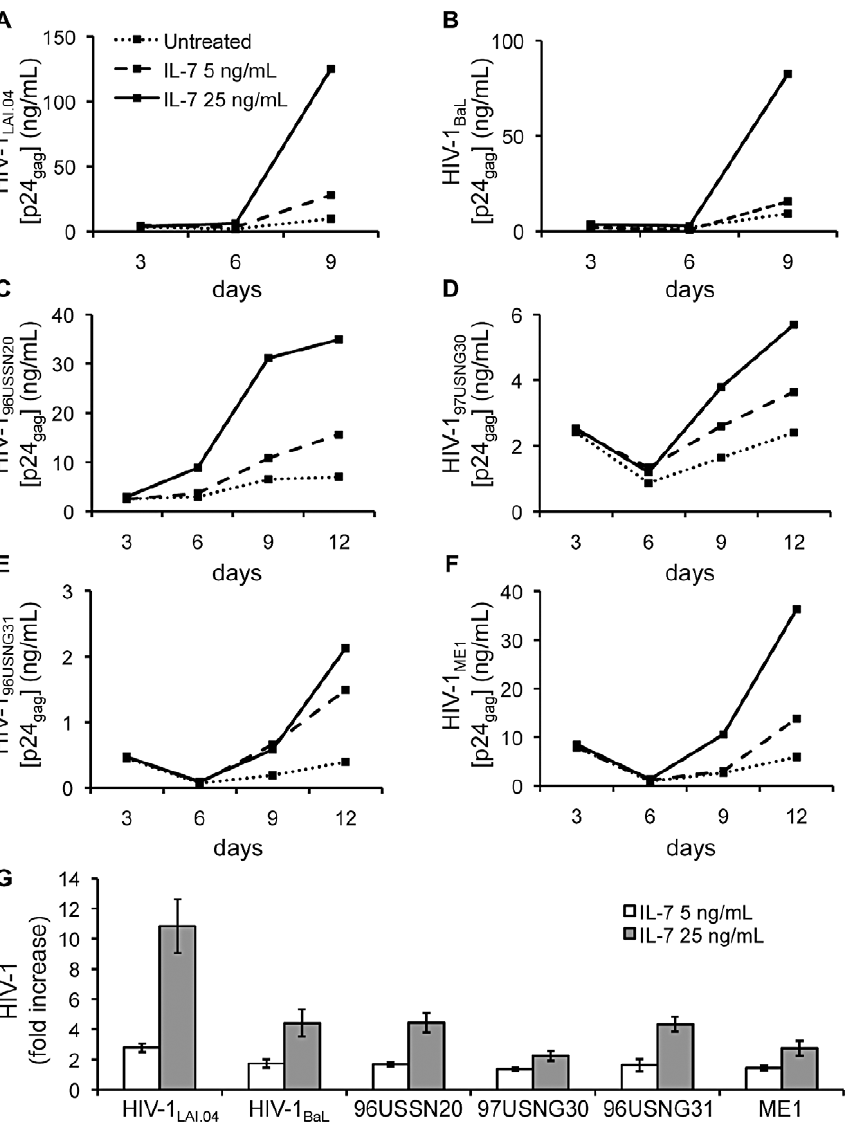
Figure 1. IL-7 enhances HIV-1 production in lymphoid tissue explants. Donor-matched lymphoid tissue blocks were inoculated with an X4 or R5 HIV-1 variant, HIV-1 LAI.04 and HIV-1 BaL respectively, or with the primary isolates HIV-1 96USSN20 (R5/X4 clade A), HIV-1 97USNG30 (R5 clade C), HIV- 1 96USNG31 (R5/X4 clade C), and HIV-1 ME1 (R5 clade B) and cultured for 9 or 12 days in the absence or presence of recombinant human IL-7 5 or 25 ng/ mL. HIV-1 replication was monitored from measurements of HIV-1 p24 gag accumulated in culture media over 3-days periods. Presented are kinetics of the release of HIV-1 p24 gag in culture media of tissue blocks inoculated with HIV-1 LAI.04 ( A ), HIV-1 BaL ( B ), and primary isolates ( C–F ) from representative donors. Each point represents pooled viral release from 27 tissue blocks over 3-days periods. ( G ) Presented are the average increases in the cumulative release of HIV-1 p24 gag in culture media of tissue blocks infected with different HIV-1 variants and treated with IL-7 5 ng/mL ( n =3– 7) or 25 ng/mL ( n =7–13) compared with infected untreated donor-matched tissue blocks (means 6 standard error of the mean (s.e.m.)).